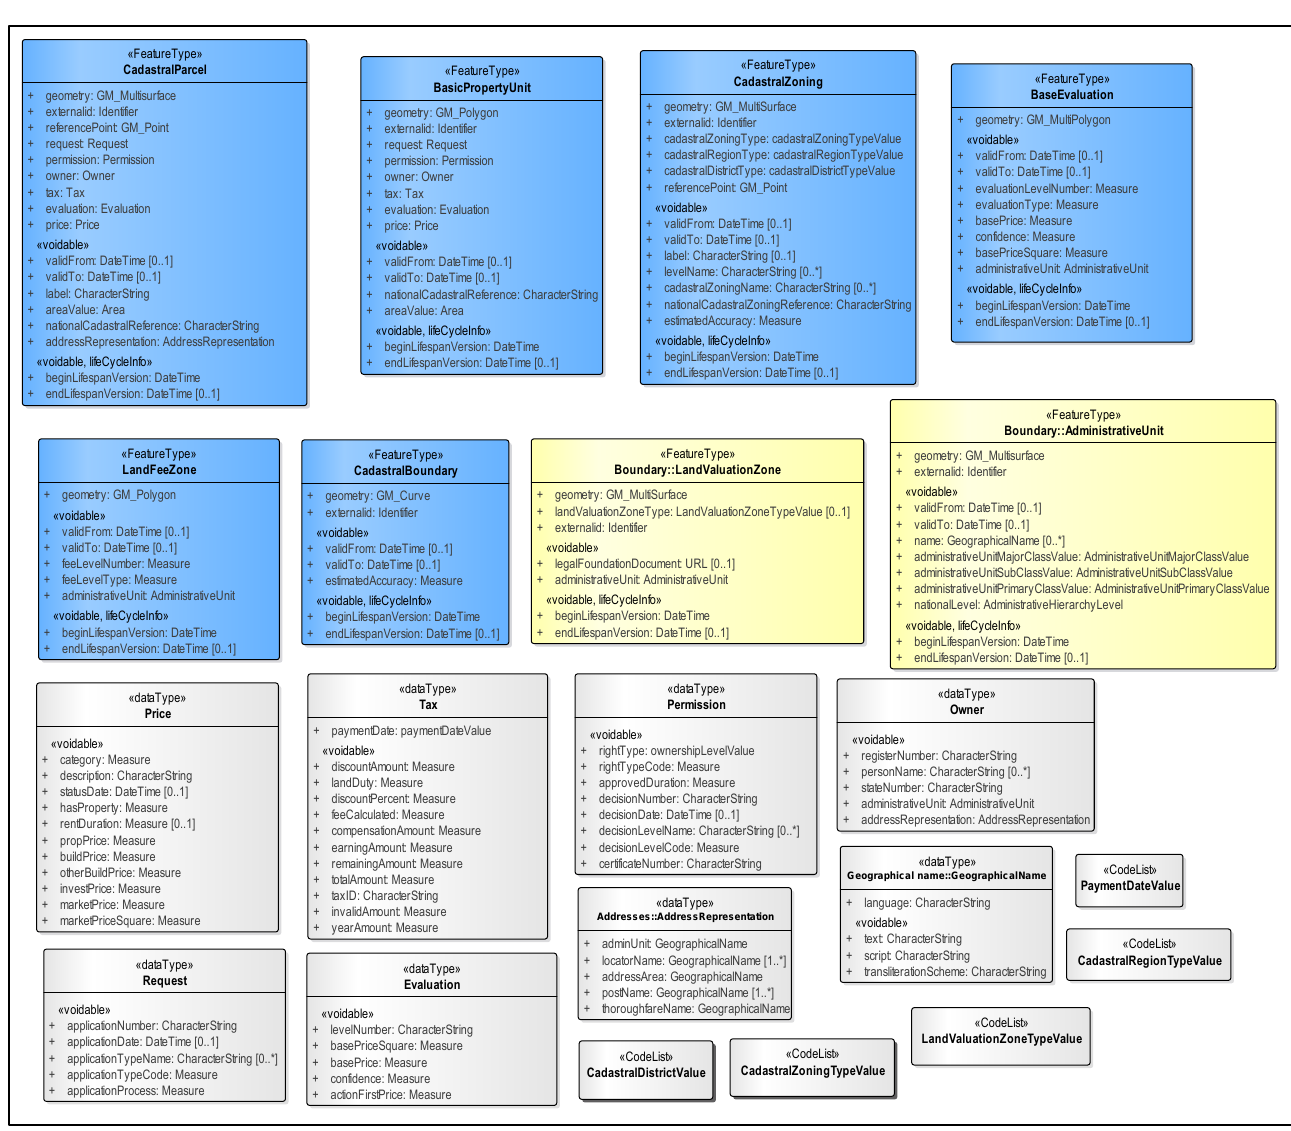
Figure 6. Data model of cadastral parcels standard. Table 1. Short description of UML class, datatype and code list of the cadastral parcel standard.